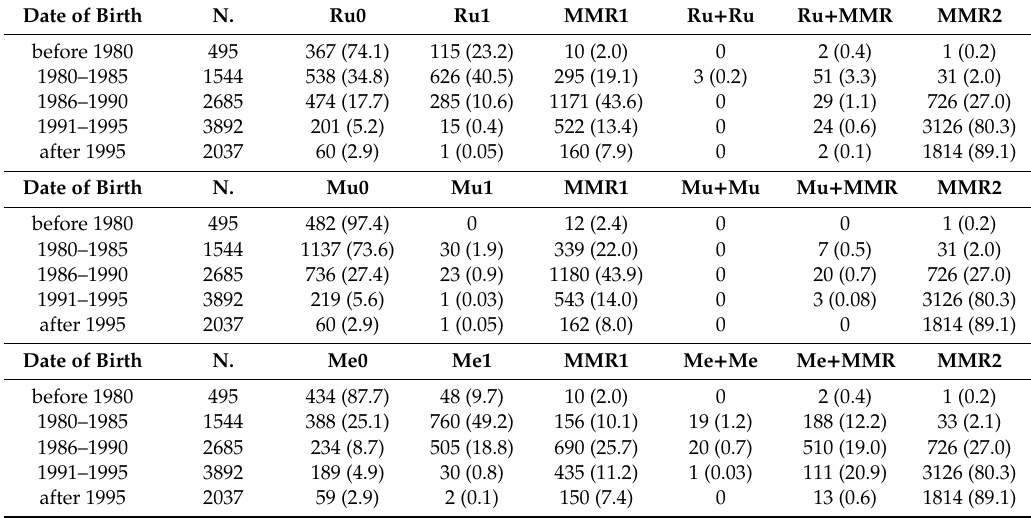
Table 1. Type of vaccination against Ru, Mu and Me (percentage in parentheses).